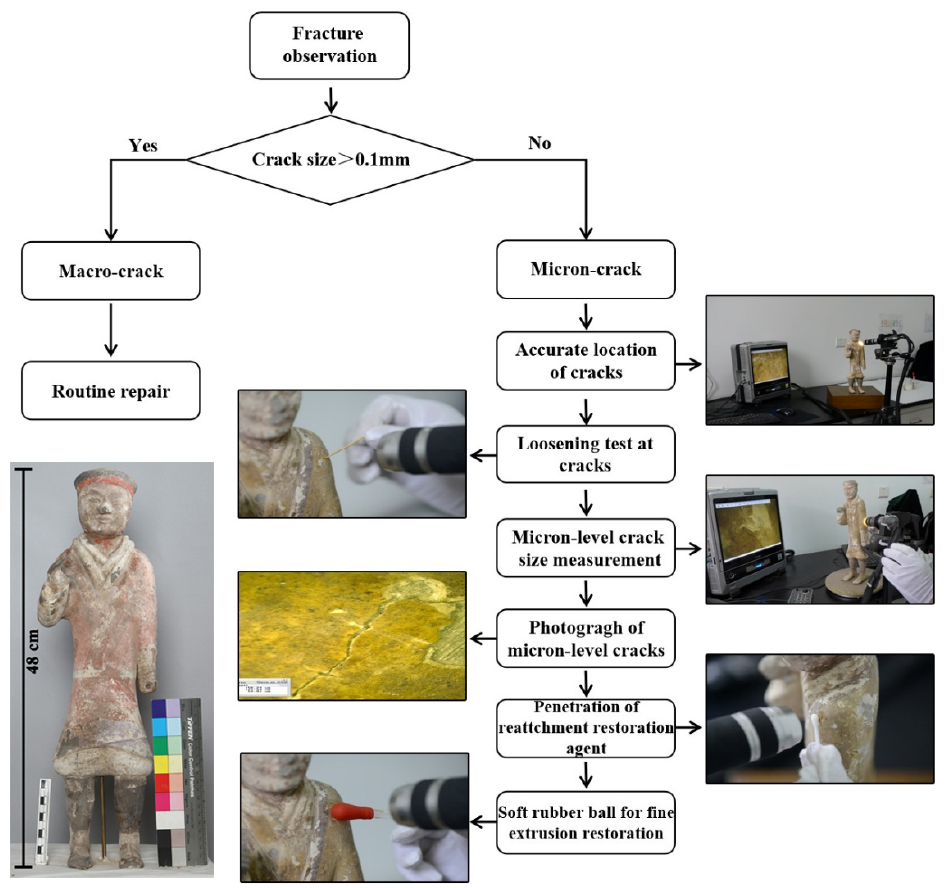
Figure 8. Process of microscopic imaging technology, assisted dynamic monitoring, and restoration. The specific repair process is outline below (see Figure 9).